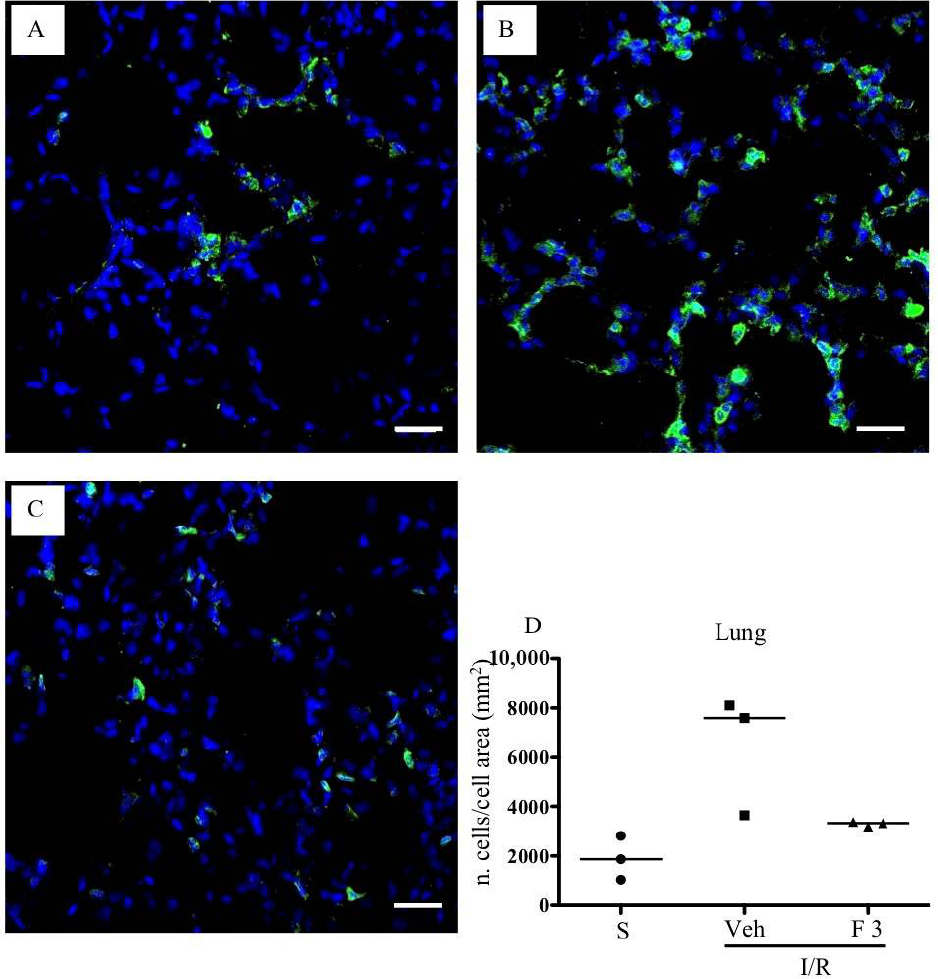
Figure 4. Effects of FTY720 on I/R-induced CD11b + cells recruitment in the lung. Representative immunofluorescence-stained sections visualizing CD11b + cells (green fluorescence) in lung tissues excised from S mice ( A ) and from I/R mice administered with vehicle ( B ) or FTY720 3 mg/kg i.v. ( C ). Images were taken at 63× magnification through the oil immersion objective (scale bar: 25 μm). Sections were counterstained with DAPI for nuclear morphology (blue fluorescence). ( D ) Ratio of the number of CD11b + cells divided by the cell total area in sections of lung tissues excised from vehicle-treated S mice ( n = 3) and I/R mice administered with the vehicle (Veh) ( n = 3) or with FTY720 3 mg/kg i.v. (F 3) ( n = 3) (horizontal bar at the median value).